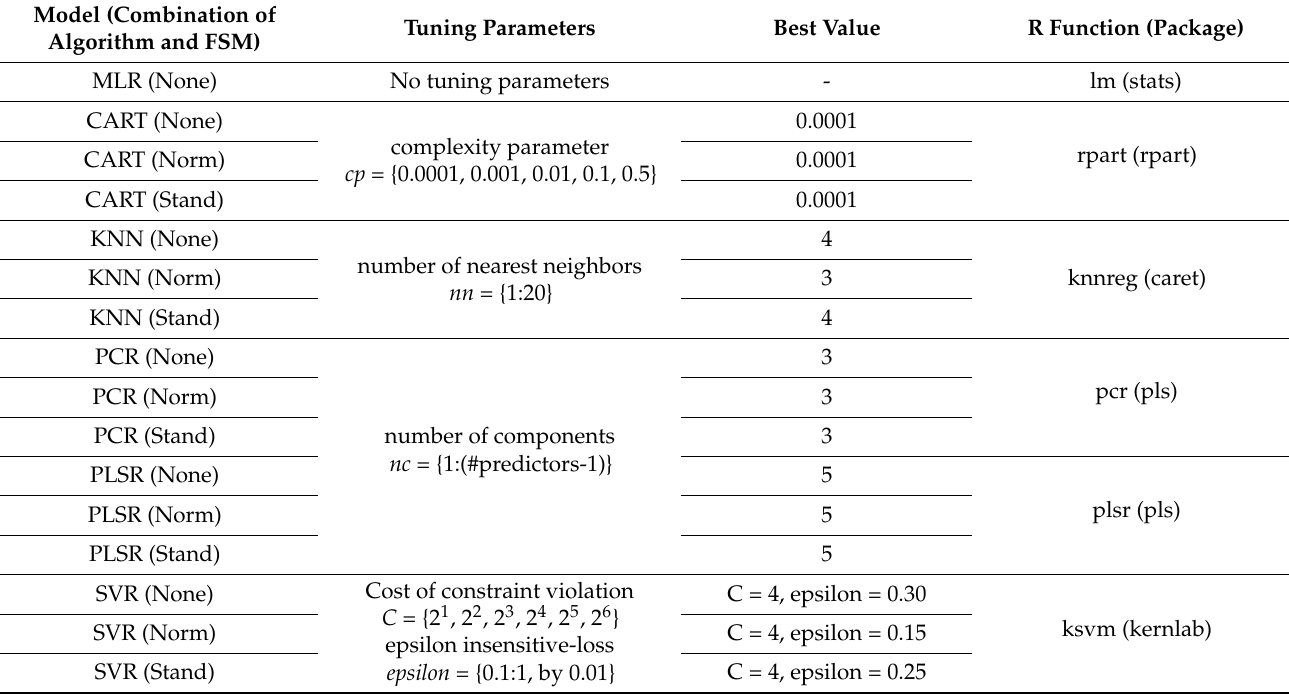
Table 2. List of examined models, values of grid and best value for tuning parameters, R func-